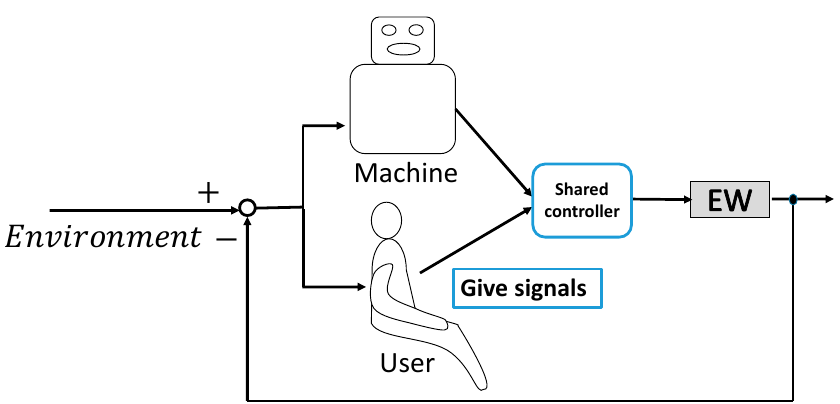
Figure 1. Construction of a shared control system for electric wheelchairs (EWs).